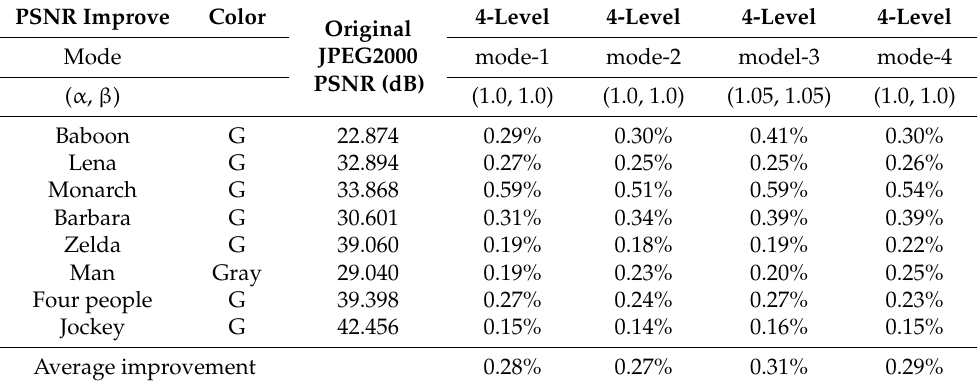
Table 22. Improvement percentage of PSNR with proposed algorithm applying multi-level MQ